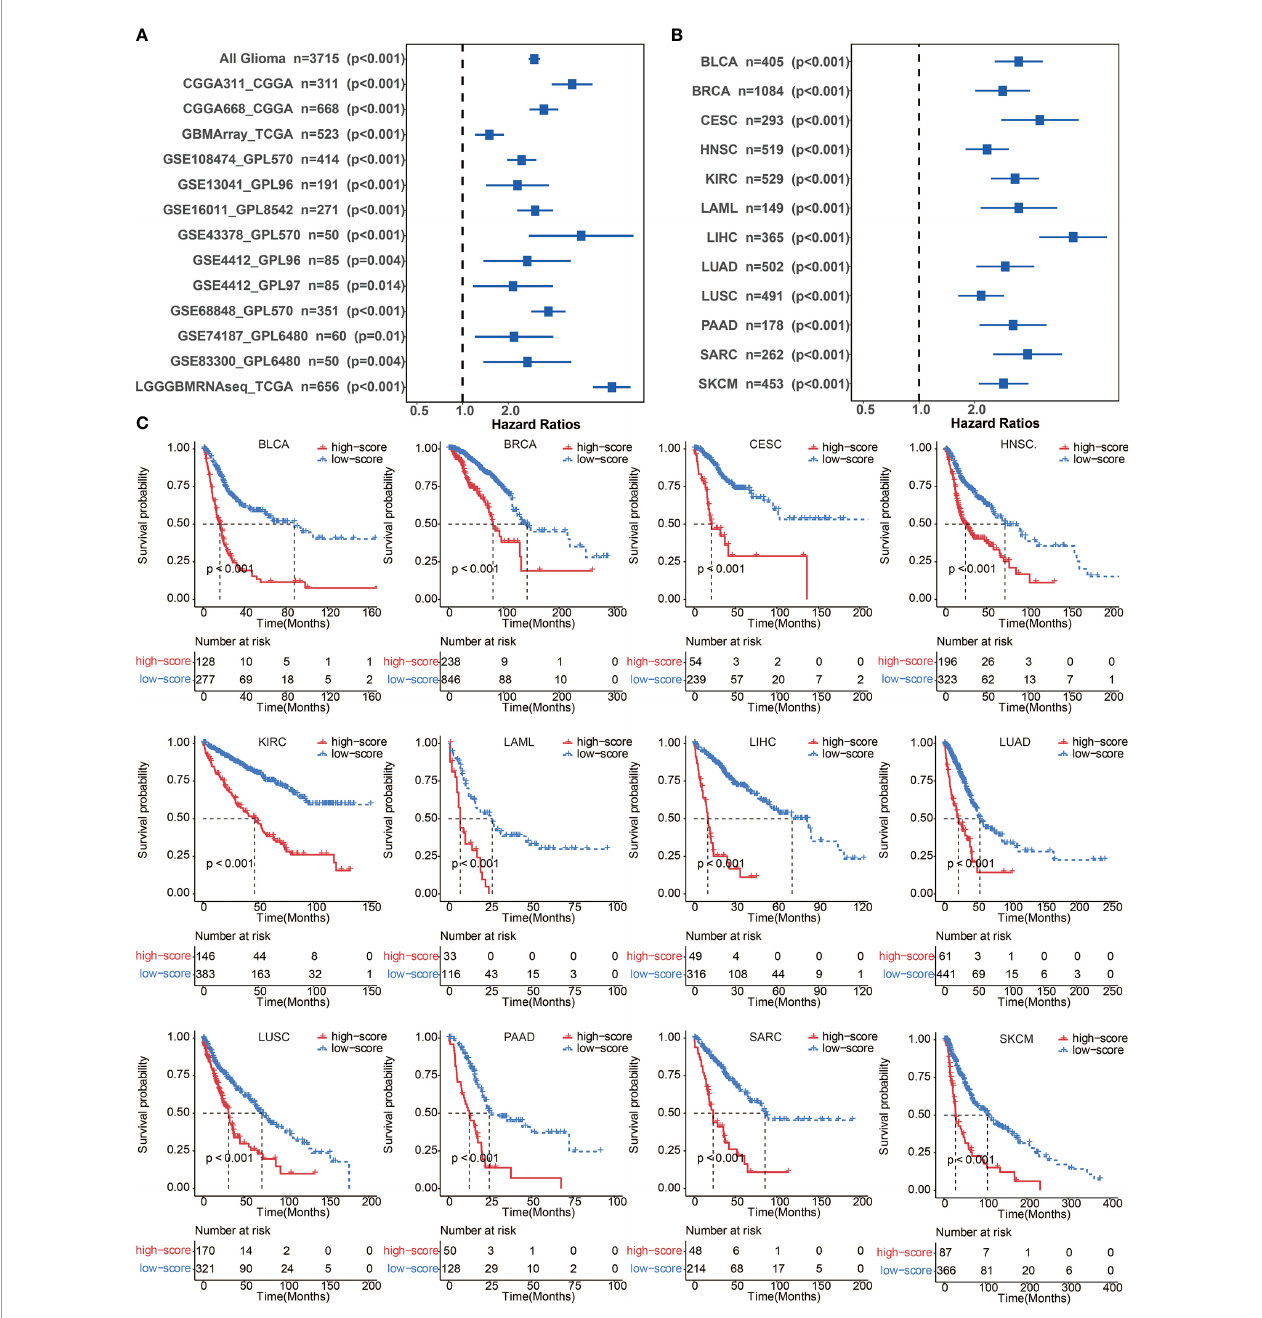
FIGURE 3 | (A) Univariate cox regression analyses to estimate the clinical prognostic value between the low/high ICP score groups in independent glioma datasets. (B) Univariate cox regression analyses to estimate clinical prognostic value between low/high ICP score groups in 12 independent cancer types in TCGA. The length of the horizontal line represents a 95% con fi dence interval for each group. The vertical dotted line represents the hazard ratio (HR) in all patients. (C) ICP score was developed in 12 independent cancer types in TCGA. Kaplan – Meier curves for two ICP score groups in 12 cancer types. Log-rank test, P < 0.001. BLCA, Bladder Urothelial Carcinoma; BRCA, breast invasive carcinoma; CESC, Cervical squamous cell carcinoma and endocervical adenocarcinoma; HNSC, Head and Neck squamous cell carcinoma; KIRC, Kidney renal clear cell carcinoma; LAML, Acute Myeloid Leukemia; LIHC, Liver hepatocellular carcinoma; LUAD, Lung adenocarcinoma; LUSC, Lung squamous cell carcinoma; MESO, Mesothelioma; PAAD, Pancreatic adenocarcinoma; SARC, Sarcoma; SKCM, Skin Cutaneous